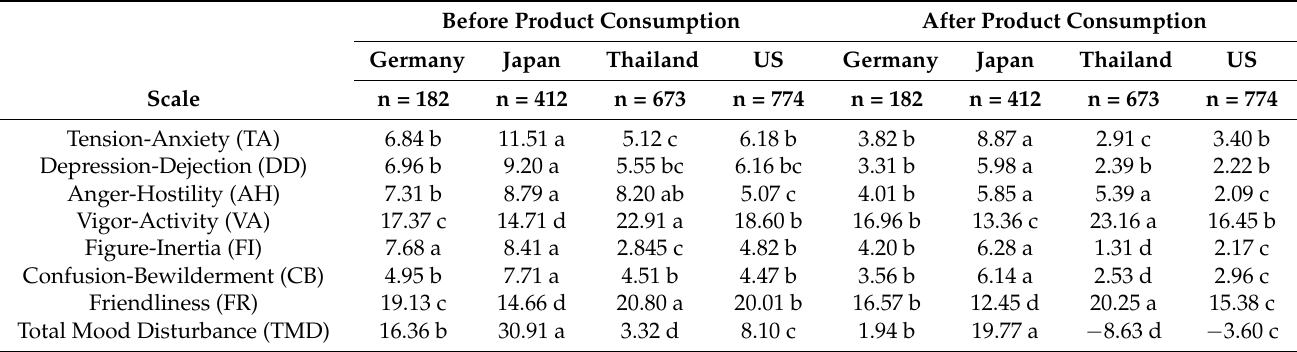
Table 5. Profile of mood states (POMS) before and after product